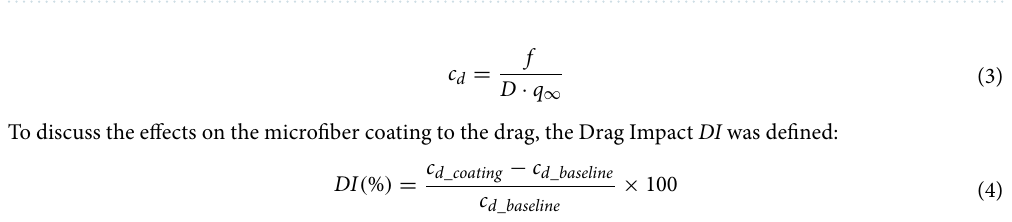
Figure 3. Time series of streaklines around the cylinder captured using smoke flow visualization. The Re based on the cylinder diameter was 6.6 × 10 4 . Symbol, S , indicates the point of flow separation. Dashed line with arrows indicates separating shear layers. Comparison of the point of flow separation for ( a ) baseline, and ( b ) microfiber